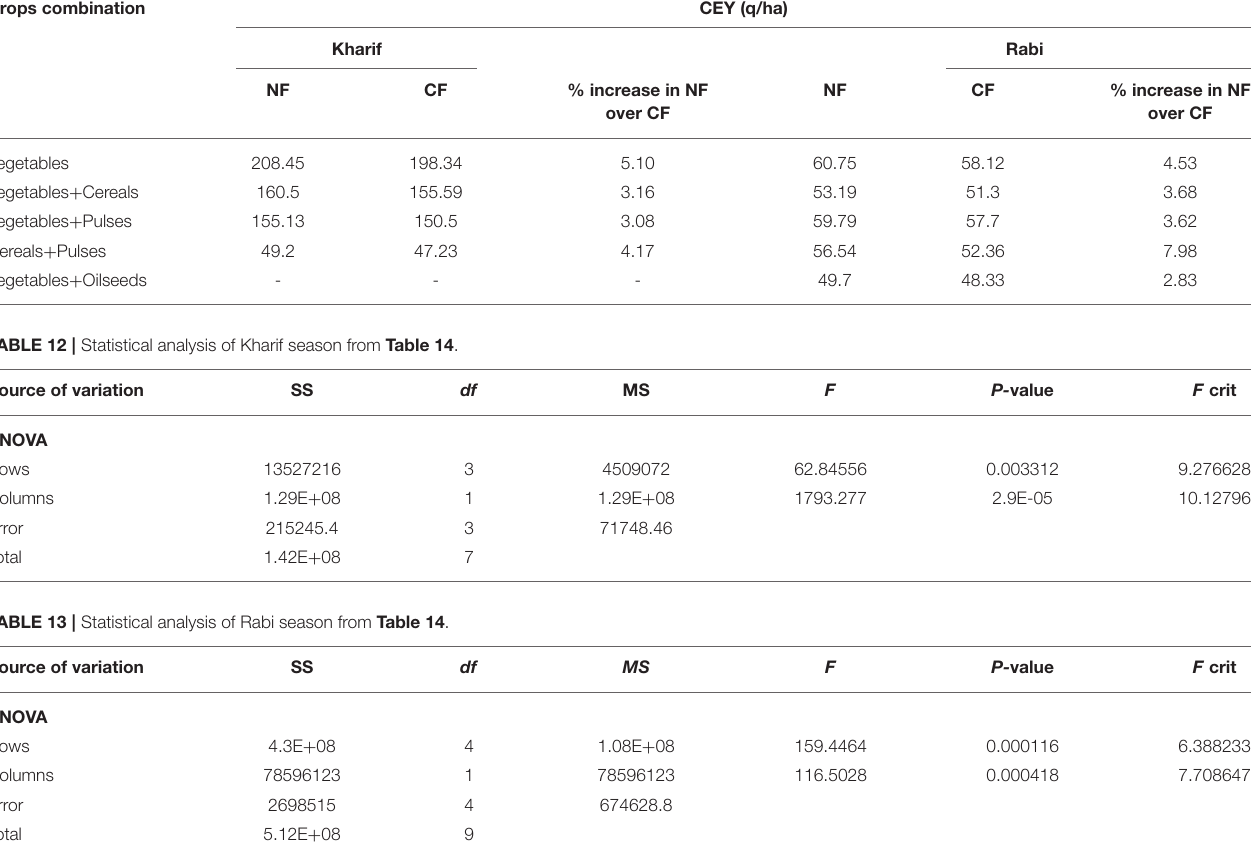
TABLE 11 | Crop equivalent yield (CEY) of various crop combinations under NF and conventional farming (CF) systems. Crops combination